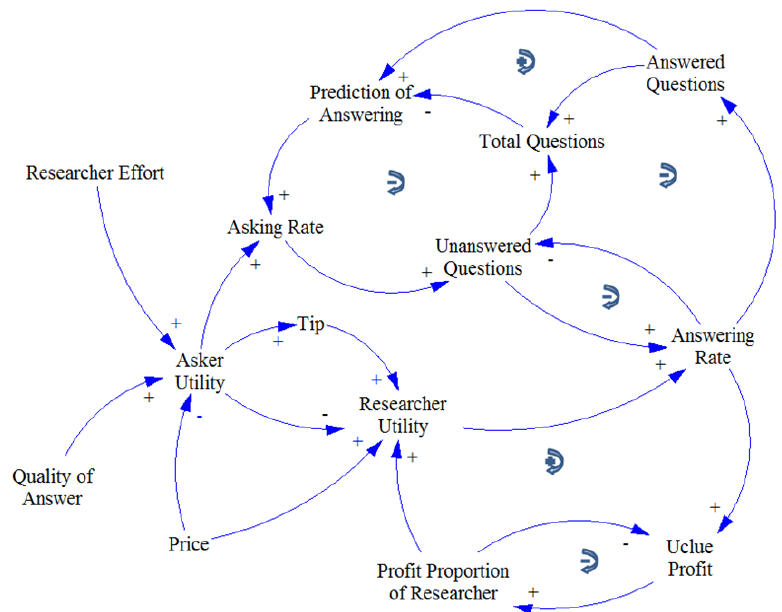
Fig. 1. The closed loop diagram of the proposed